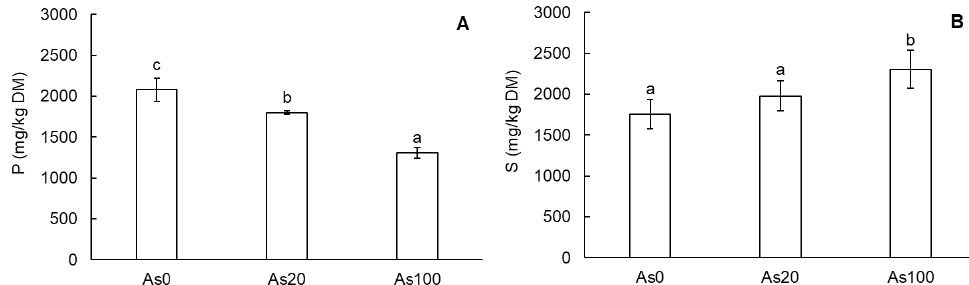
Figure 1. Content of phosphorus ( A ) and sulfur ( B ) in tubers of cherry radish. Values represent the mean ± SD. Data with the same letter are not significantly different. Different letters indicate significant differences ( p < 0.05) among treatments according to ANOVA with Tukey’s post-hoc test. Abbreviations: As0—0 mg As/kg soil (control); As20—20 mg As/kg soil; As100—100 mg As/kg soil; DM—dry matter.